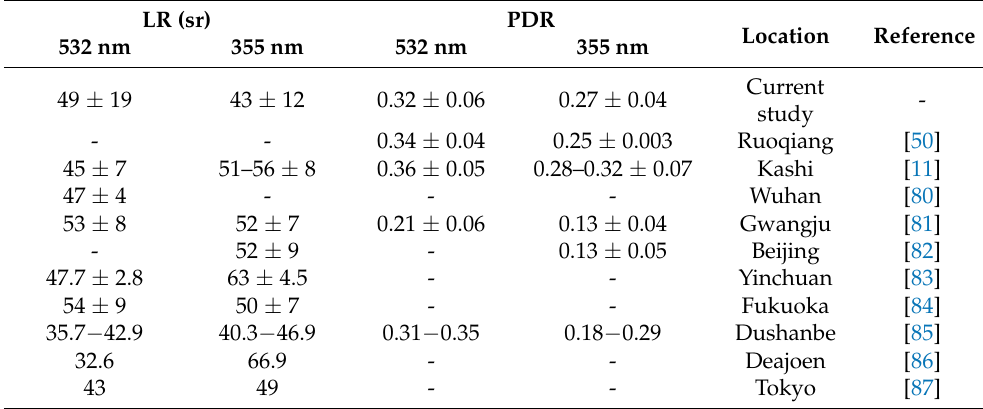
Table 2. LR and PDR of East Asian dust in this study and reported in the